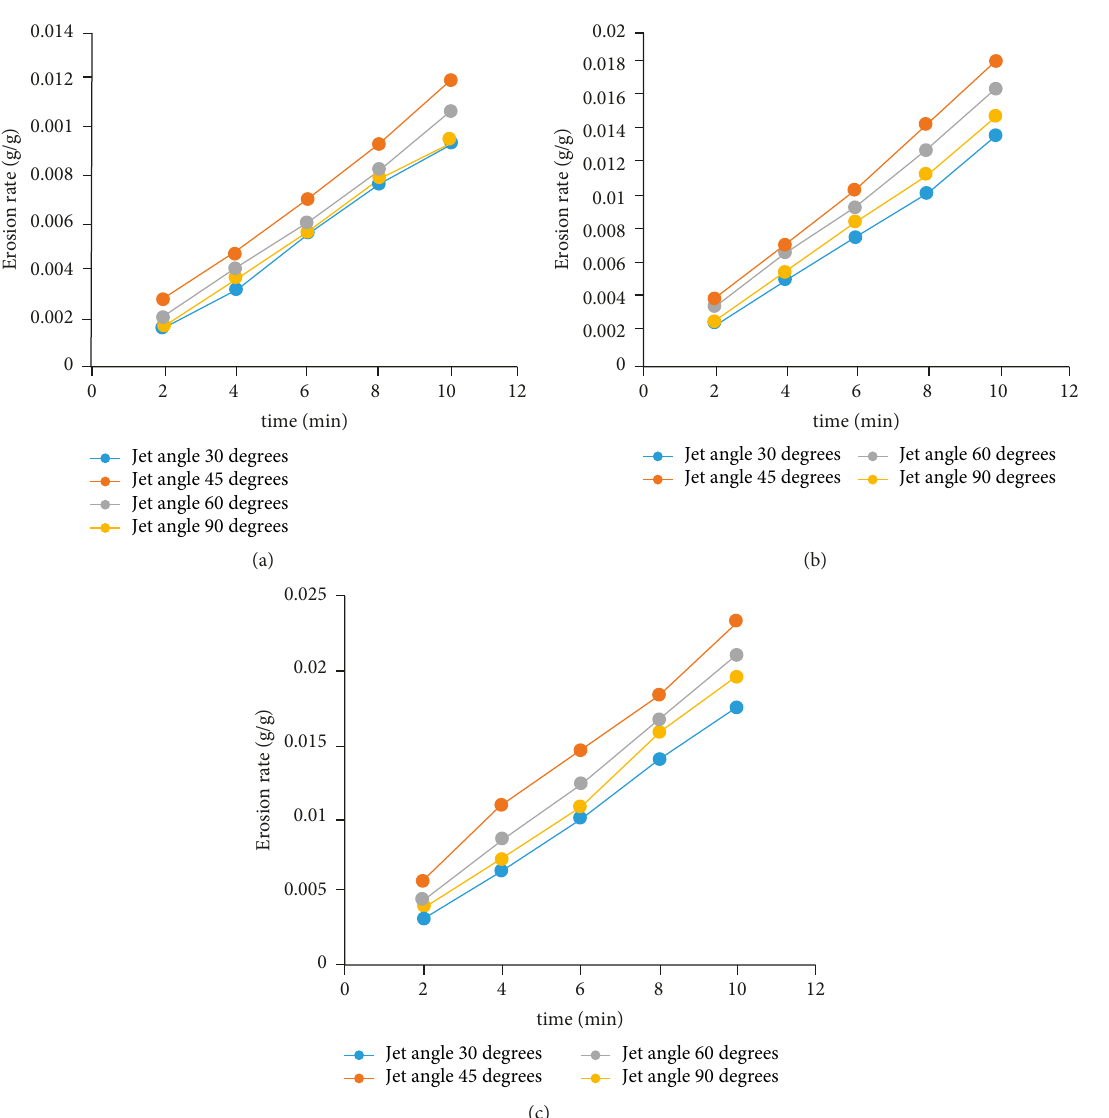
Figure 8: 5 layers glass fibre. (a) 1 bar pressure and 5% nanocarbon powder filler. (b) 1.5 bar pressure and 5% nanocarbon powder filler. (c) 2 bar pressure and 5% nanocarbon powder